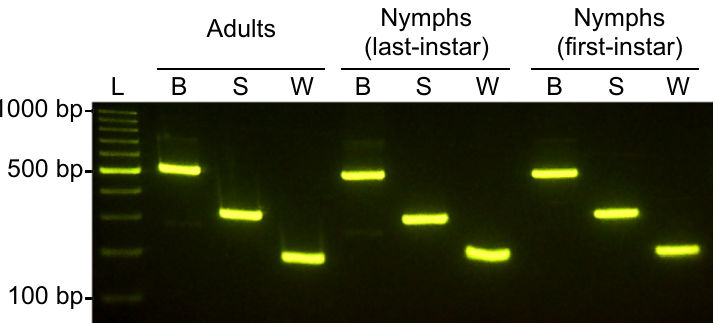
Fig 2. Detection of the three rice planthopper species by a multiplex PCR assay. L, 100 bp DNA ladder; B, Nilaparvata lugens ; S, Laodelphax striatellus ; W, Sogatella furcifera